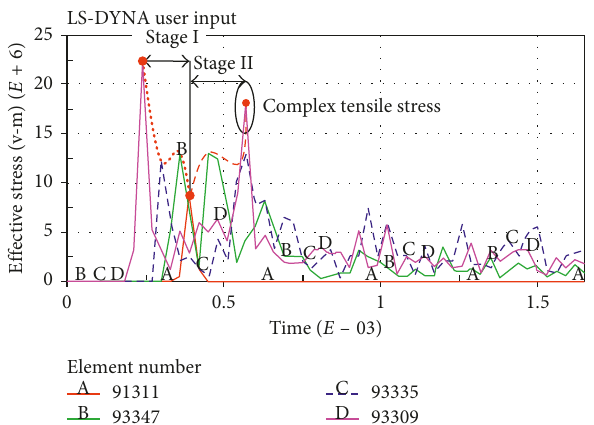
Figure 16: Strains’ peak curve for different holes’ spacing along the